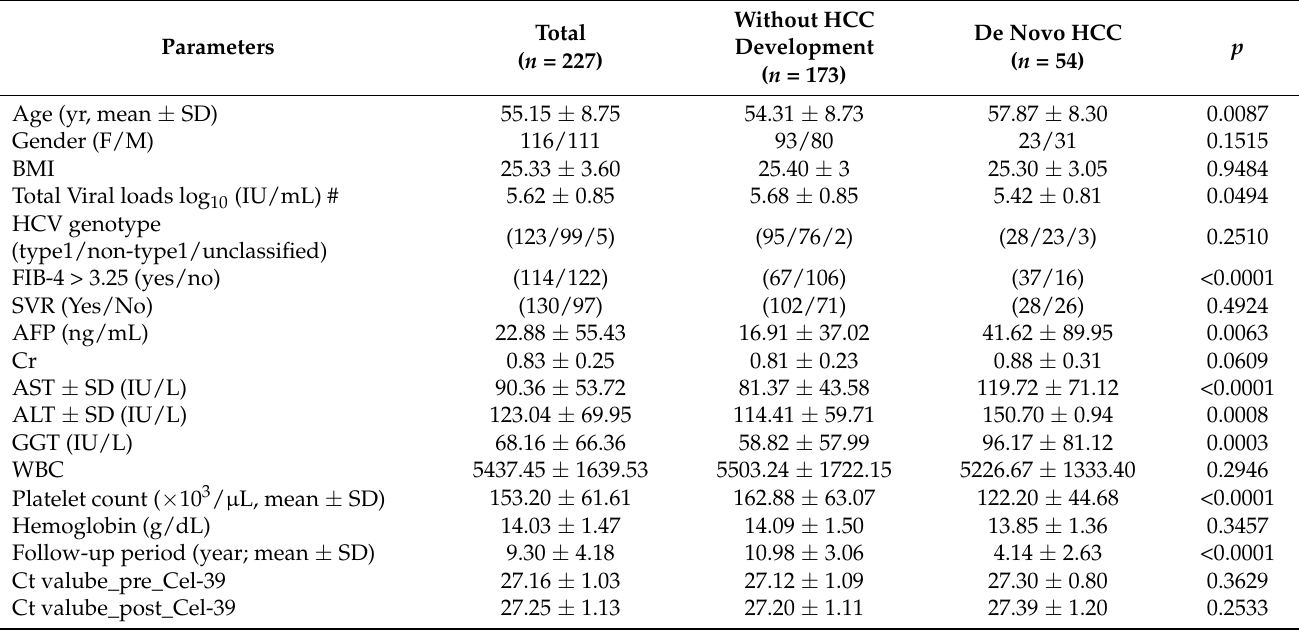
Table 1. Participant CHC patients’ characteristics.